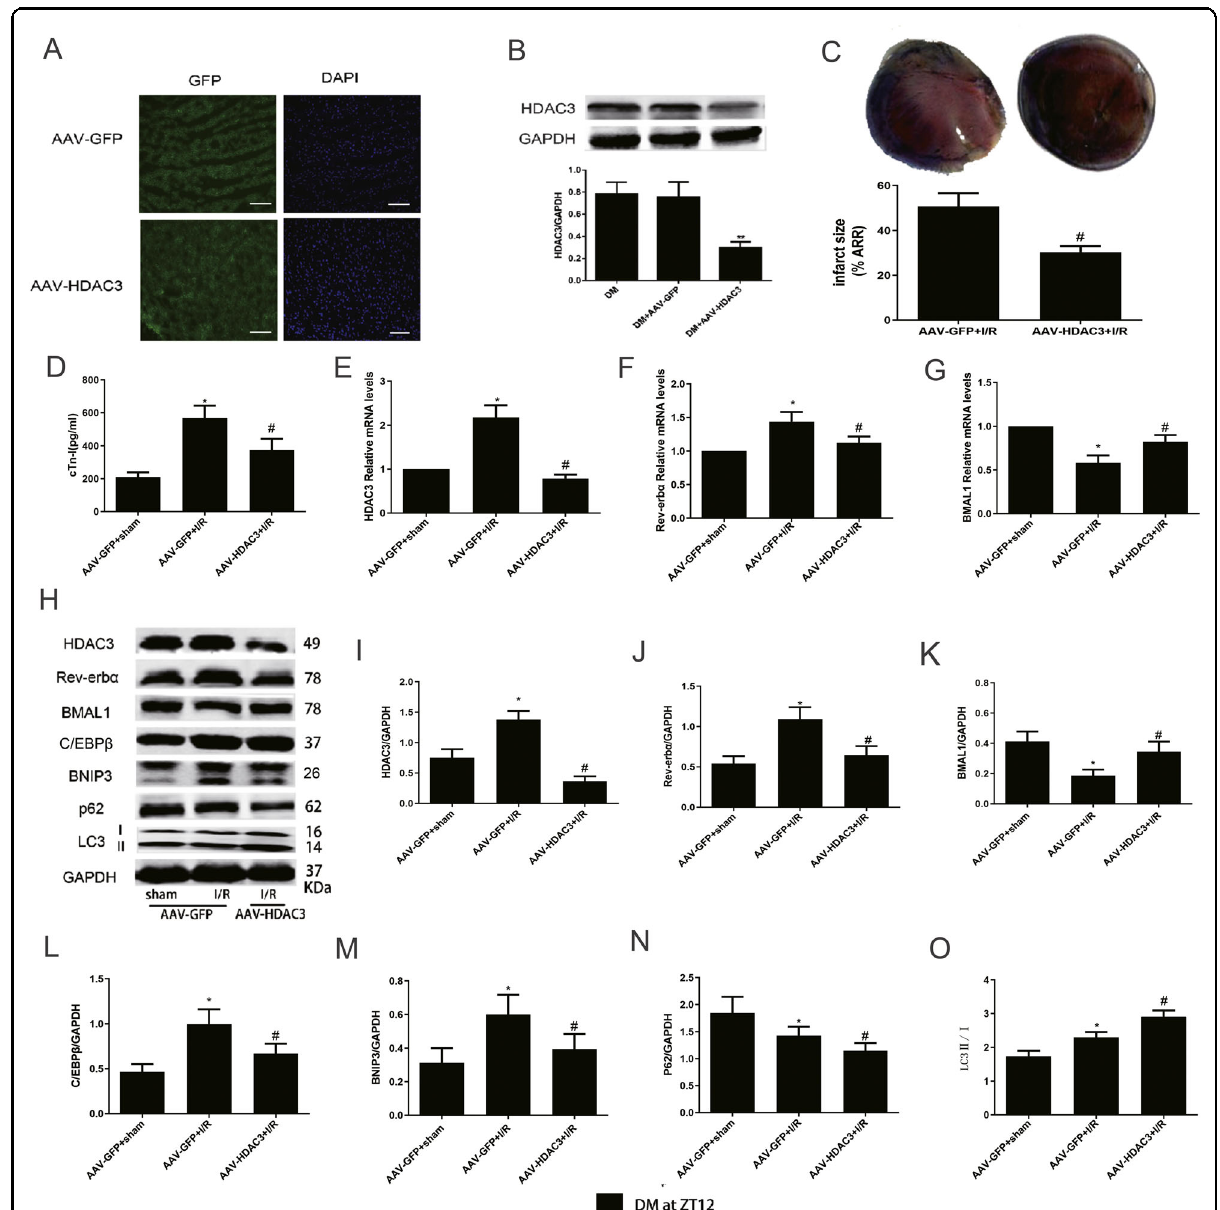
Fig. 4 Genetic knockdown of HDAC3 recovered mitophagy status through the Rev-erb α /BMAL1 circadian pathway and signi fi cantly attenuated diabetic MI/RI. A Representative images of myocardial tissue GFP and DAPI was detected by immuno fl uorescence staining after AAV- GFP and AAV-HDAC3 transfection, scale bar = 100 μ m. B Protein expression of HDAC3 was analysed by western blotting. C Infarct size was measured by TTC. D The serum level of cTn-I ( D ) was measured by ELISA assay kits. E – G The mRNA expression of HDAC3 ( E ), Rev-erb α ( F ), and BMAL1 ( G ) were analysed by qPCR. H – O The protein levels of HDAC3 ( I ), Rev-erb α ( J ), BMAL1 ( K ), C/EBP β ( L ), BNIP3 ( M ), P62 ( N ), and LC3 II/I ( O ) were measured by western blotting. n = 6 per group. ** P < 0.01 versus DM; * P < 0.05 versus AAV-GFP + sham; # P < 0.05 versus AAV-GFP +